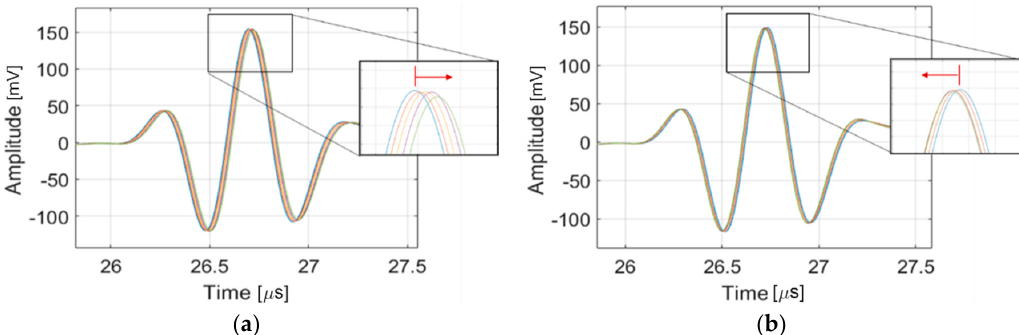
Figure 10. Received signals obtained in the acoustoelastic coe ffi cient measurements: ( a ) Measurement of K 1 —The peak moves to the right because the velocity of surface wave in the direction of tensile stress decreases with increasing stress; ( b ) Measurement of K 2 —The peak moves to the left because the velocity of surface wave in the direction perpendicular to the tensile stress increases with increasing stress.